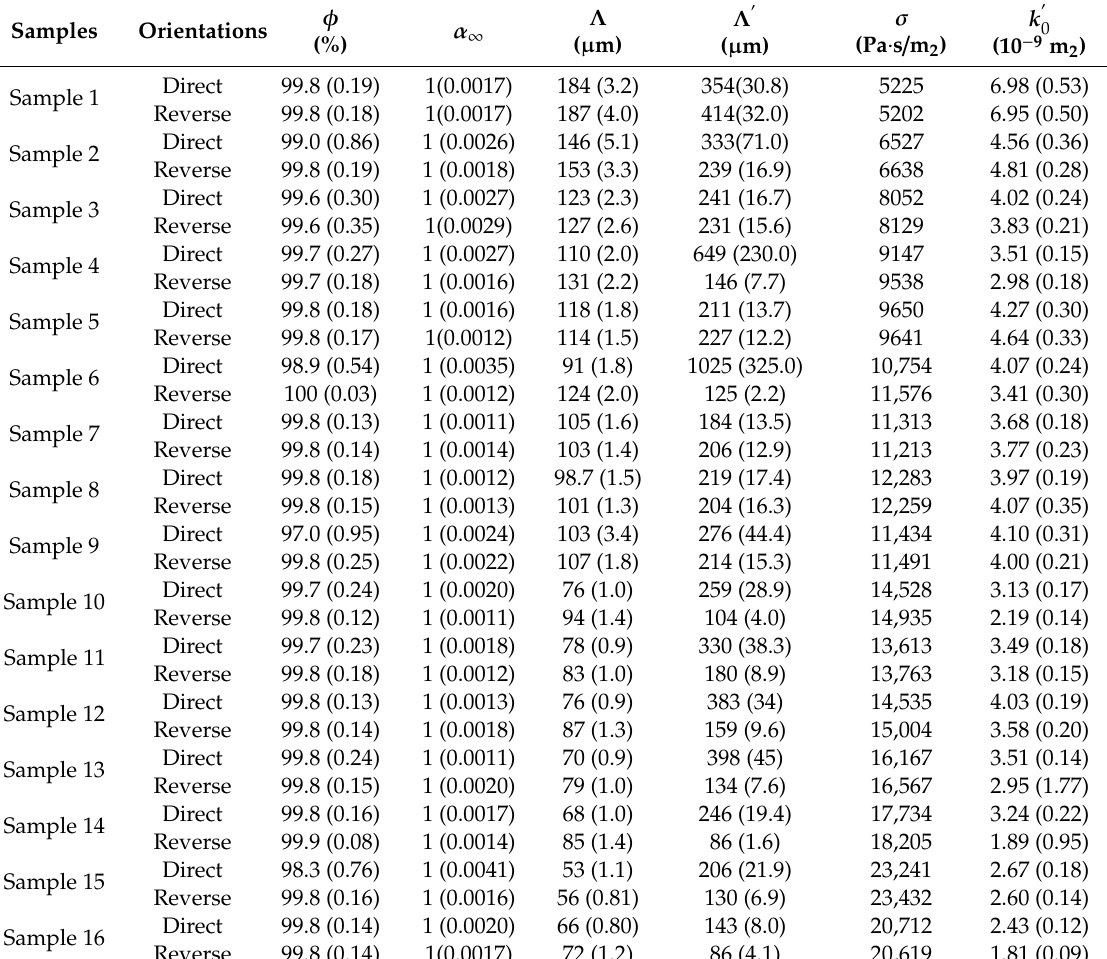
Table 2. Inferred non-acoustic parameters of polyester